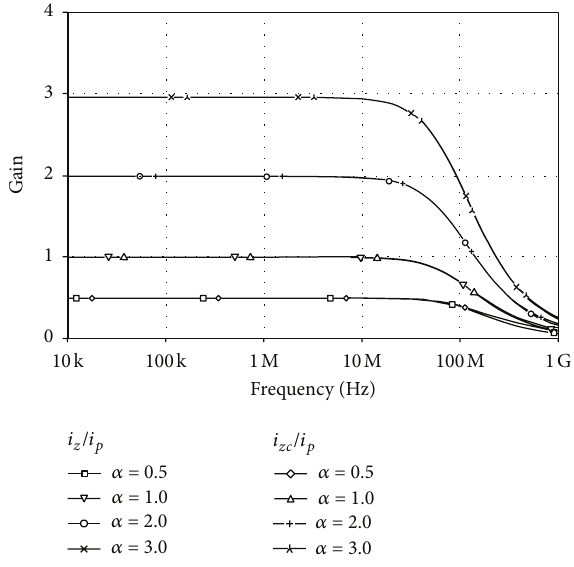
Figure 9: Frequency responses of 𝑖 𝑧 /𝑖 𝑝 and 𝑖 𝑧𝑐 /𝑖 𝑝 for different values of 𝐼 𝐵𝐵